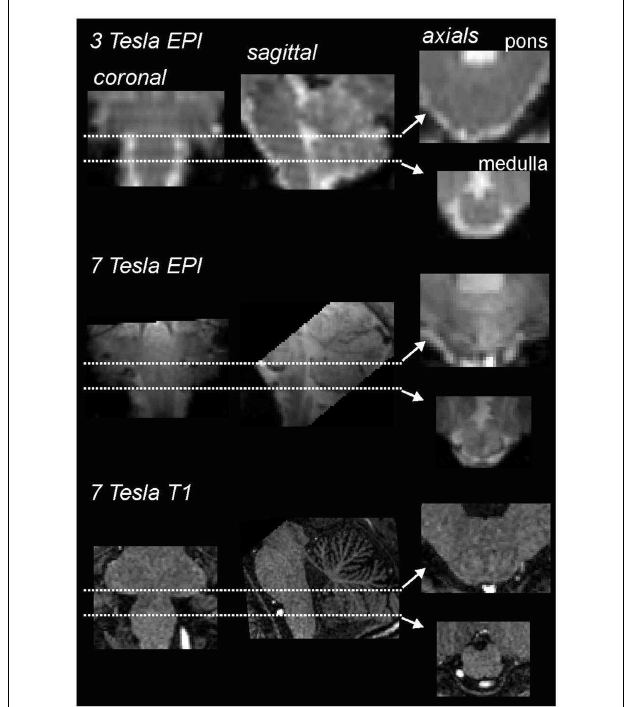
FIGURE 1 | Comparison of coronal, sagittal, and axial echo-planar images (EPI) through the medulla collected using a 3T (top row) and 7T (middle row) MRI scanner collected in the same individual . Note that the images collected using the 7T scanner have finer spatial resolution and greater gray/white differentiation.The bottom row shows a series of T1-weighted anatomical images also collected using a 7T MRI